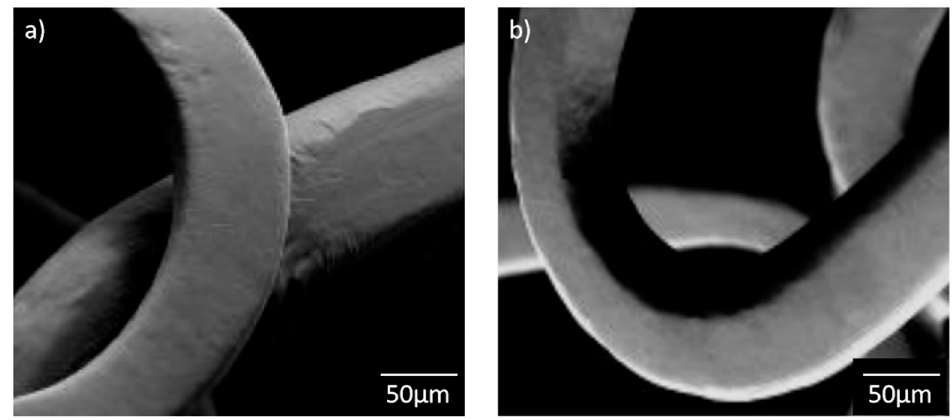
Figure 9. SEM images for ( a ) P3; ( b ) P8 sample; both samples 400 × magnification.